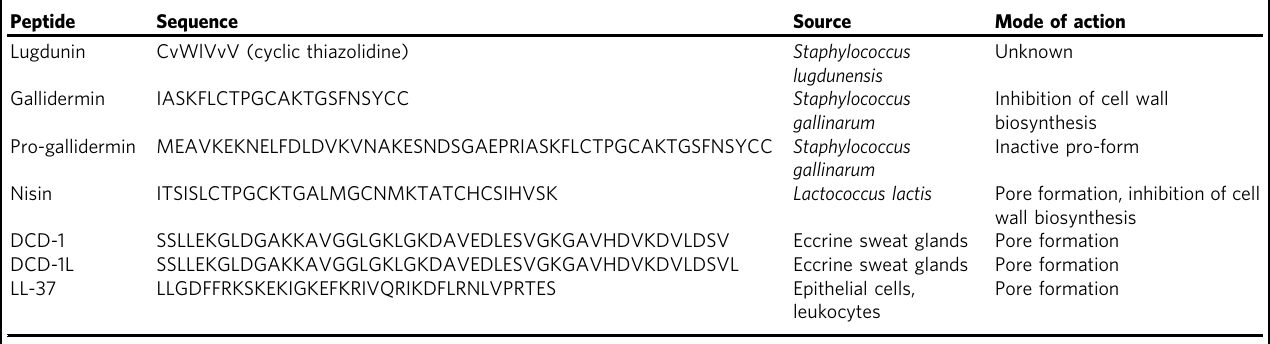
Table 1 Overview of bacteriocins and human AMPs used in this